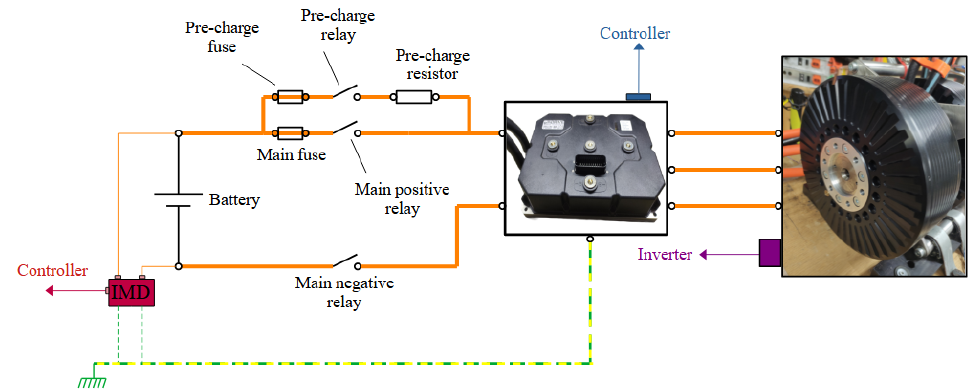
Figure 15. Diagram of the connection of the batteries to the